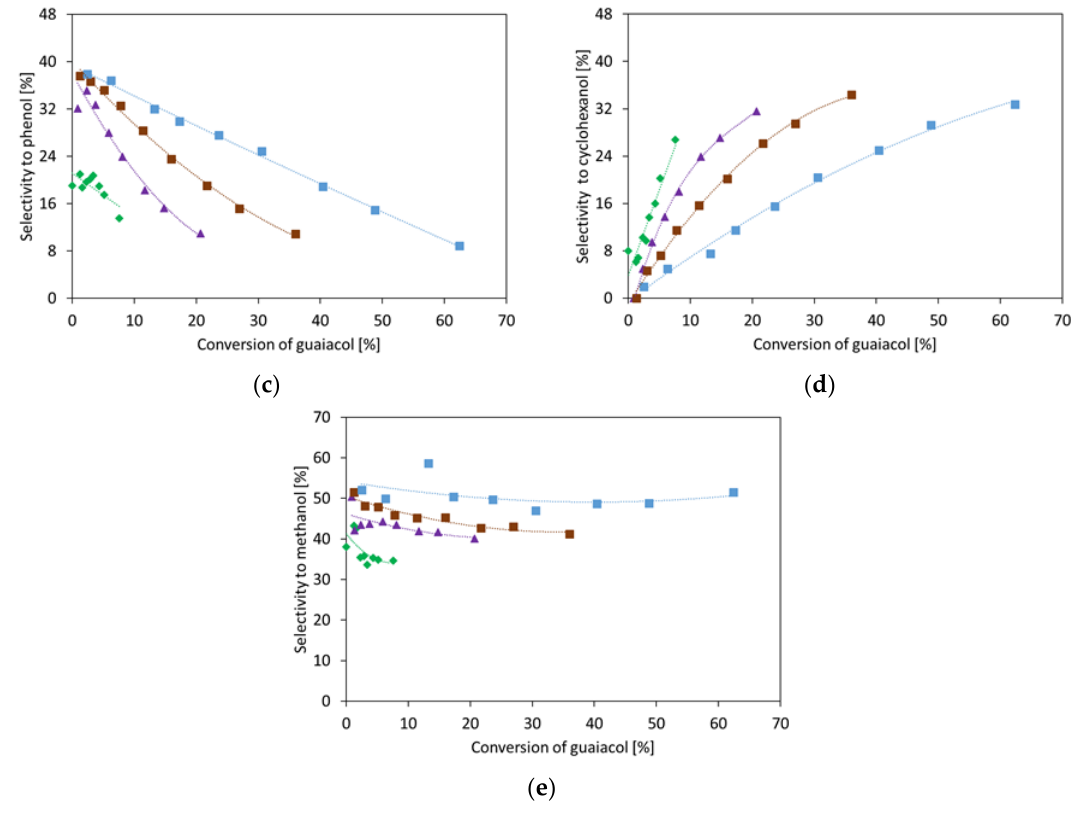
Figure 5. ( a ) Conversion of guaiacol. Selectivity to ( b ) methoxycyclohexanol, ( c ) phenol, ( d ) cyclohexanol, and ( e ) methanol at 70 °C in guaiacol:furfuryl alcohol mixtures of 100:0, 90:10, 80:20, and 50:50 mol:mol.